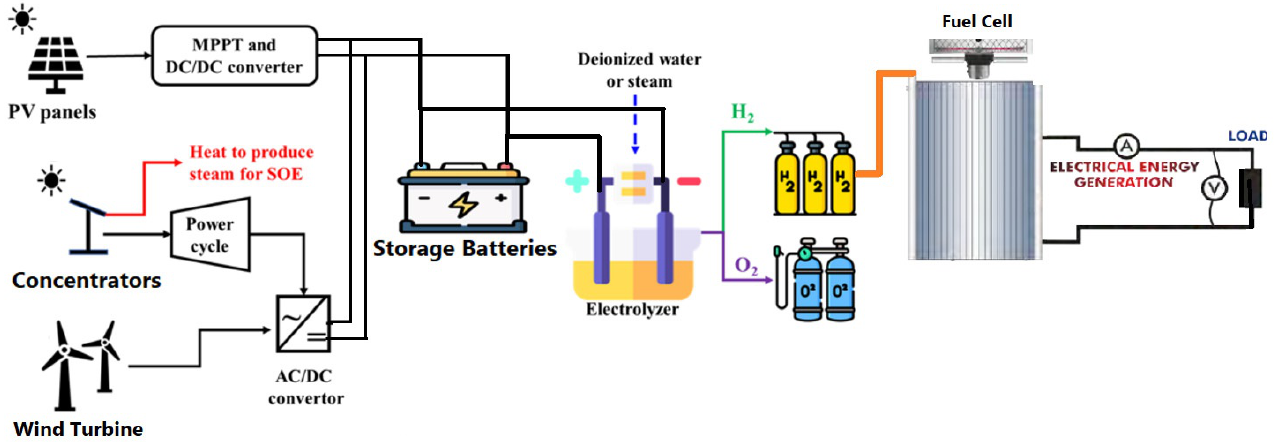
Figure 17. Principal of solar/wind hydrogen production systems.